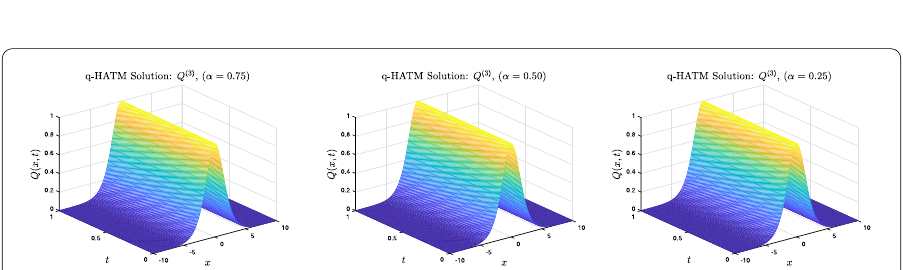
Figure 13 q-HATM Q (3) -solutions with different α when (cid:2) = –1, A = r = 0.1, B = 3, and n = 1 for Example 4.3